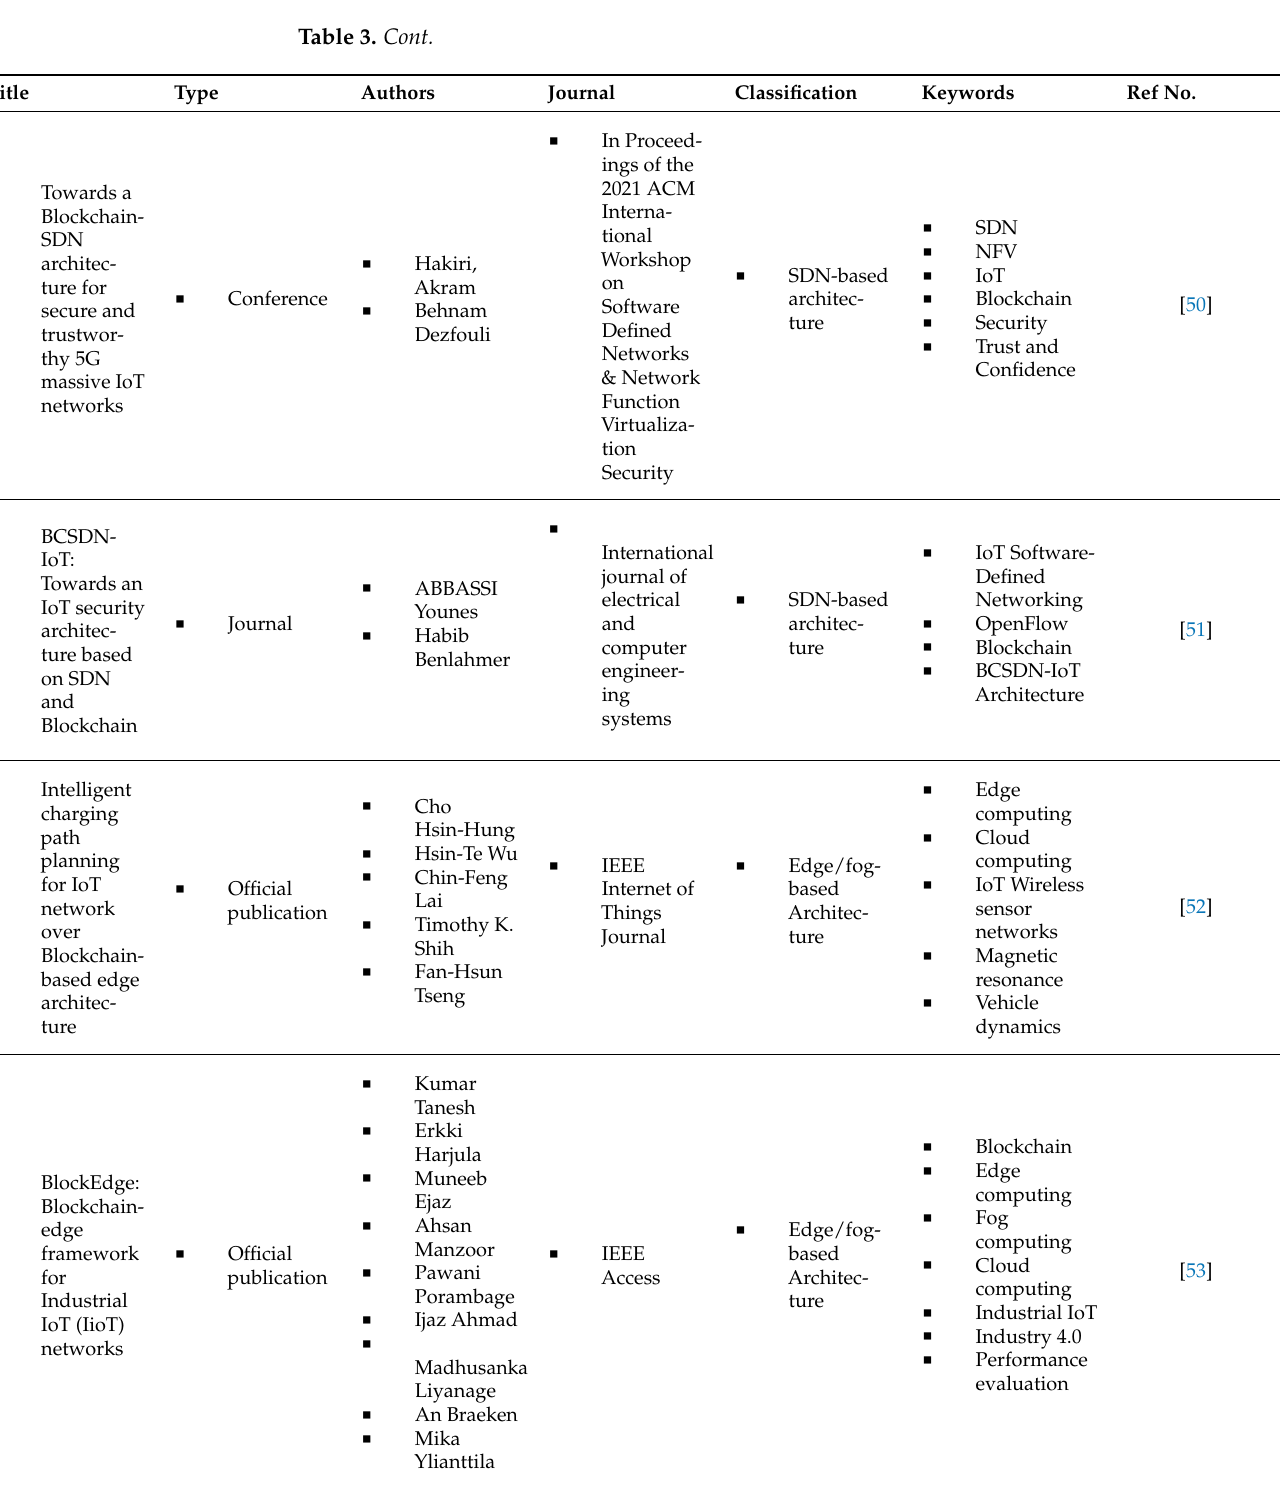
Table 3. Selected Articles.